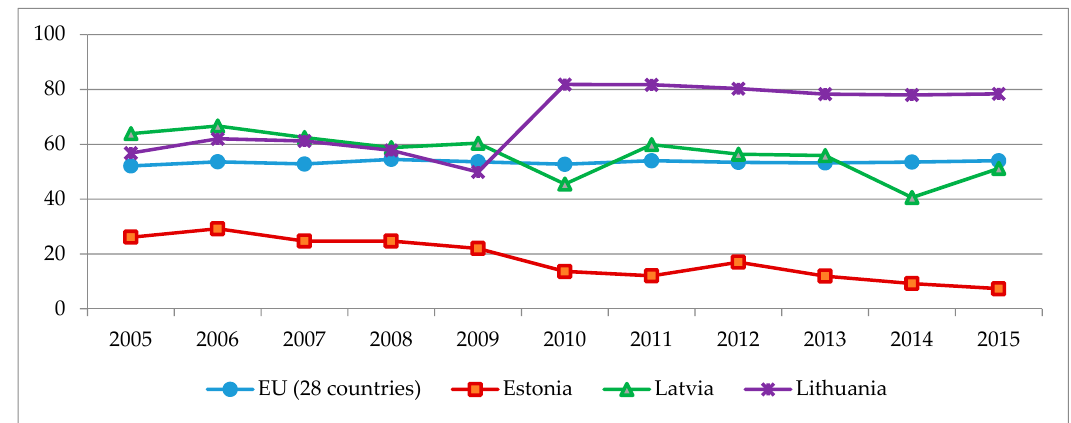
Figure 14. The trends of energy dependency rates, %.